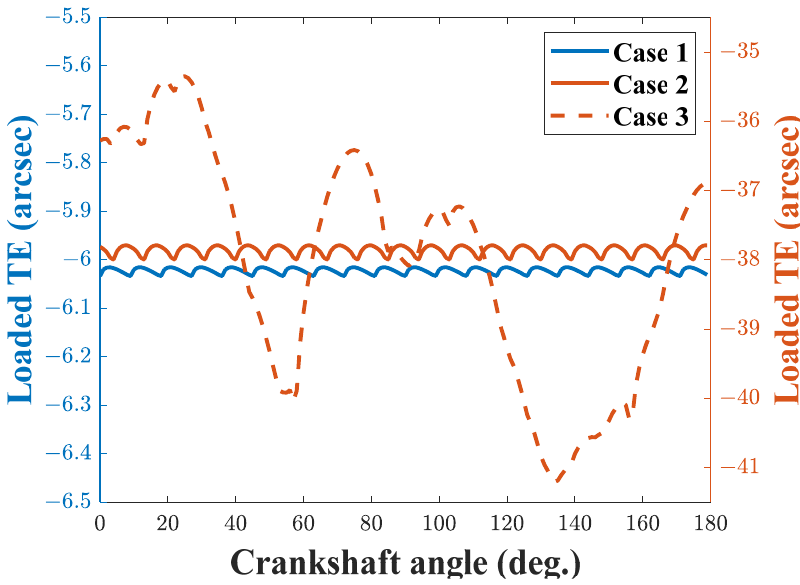
Figure 14. Comparisons of the loaded TE for three cases.